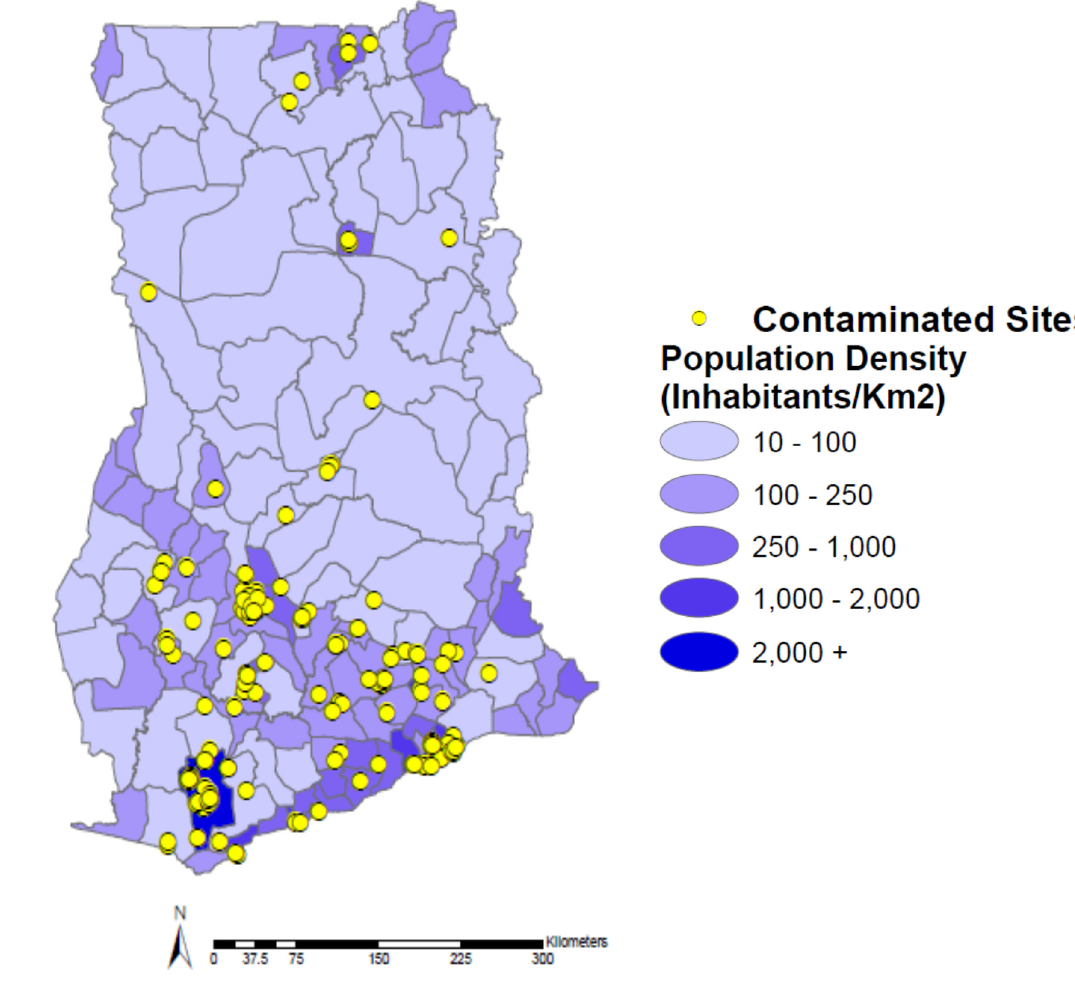
Figure 3. Population density of Ghana by administrative district and contaminated